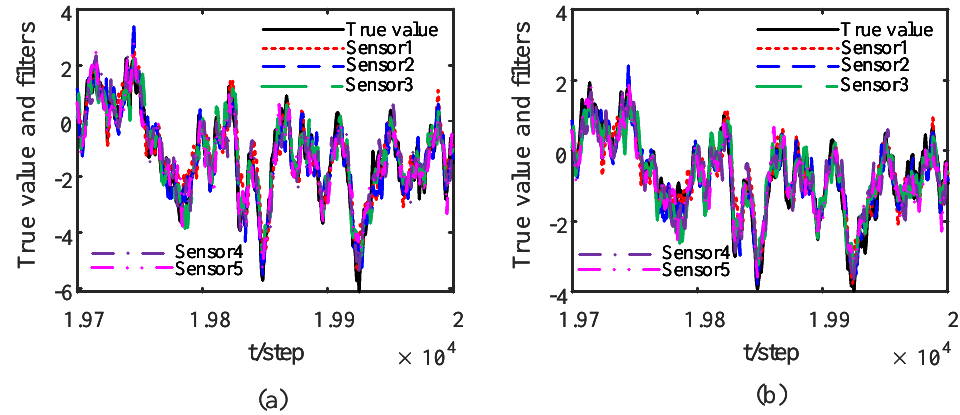
Figure 7. Tracking effects of DSTFCDs of five sensor nodes: ( a ) tracking for the position; ( b ) tracking for the velocity (authors’ own